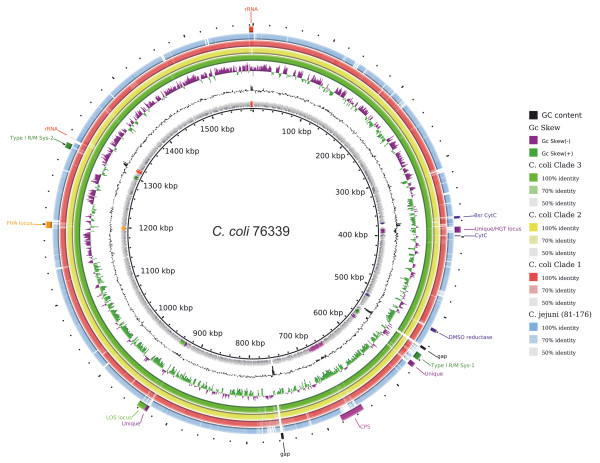
Circular plot of the C. coli 76339 chromosome, with highlighted features rRNA, biotin sulfide reductase (bsr), cytochrome C (CytC), DMSO reductase, Type I restriction modification systems, lipooligosaccharide locus (LOS) and filamentous haemagglutinin domain protein (FHA) locus. GC content (black circles) and GC skew (green and purple circles) are represented. C. jejuni 81–176 and the pangenomes of each C. coli clade were compared.